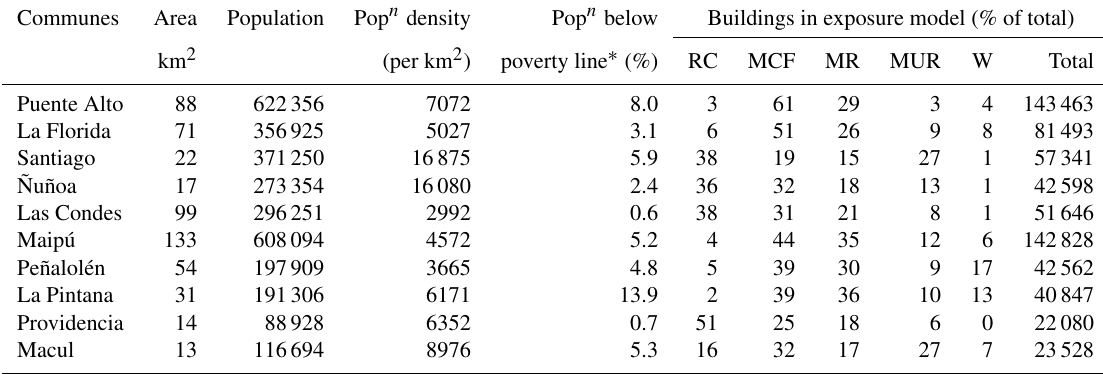
Macul 13 116694 8976 5.3 16 32 17 27 7